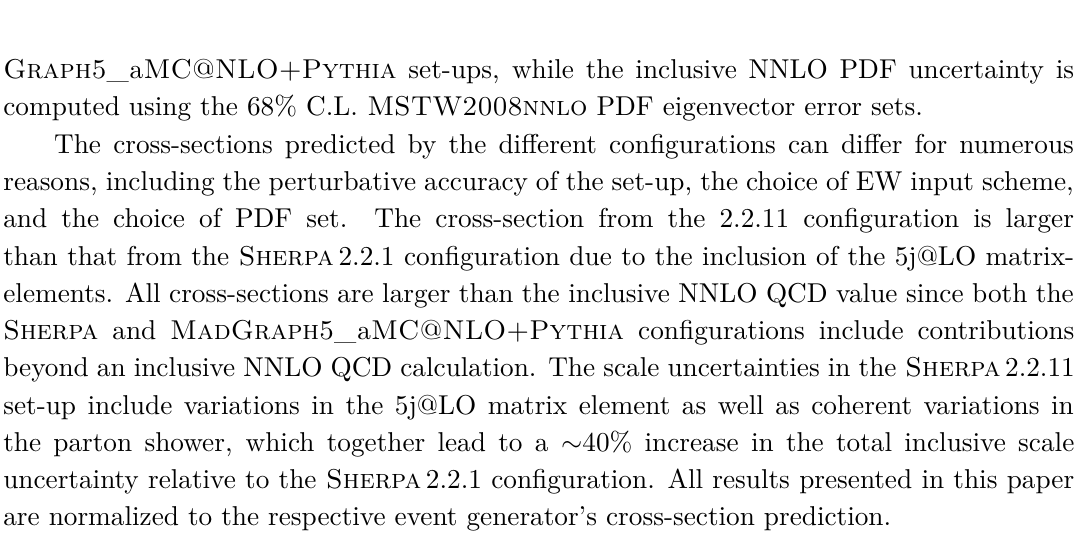
Graph5_ a MC@NLO+Pythia set-ups, while the inclusive NNLO PDF uncertainty